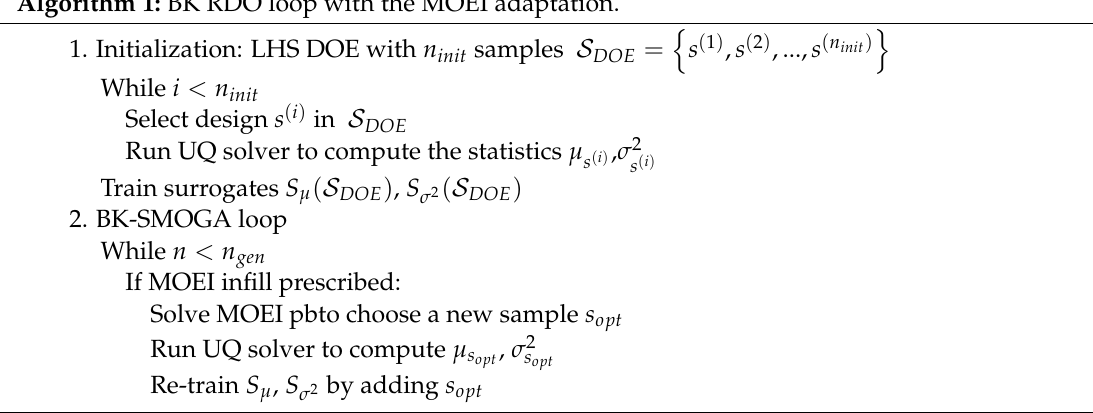
Algorithm 1: BK RDO loop with the MOEI